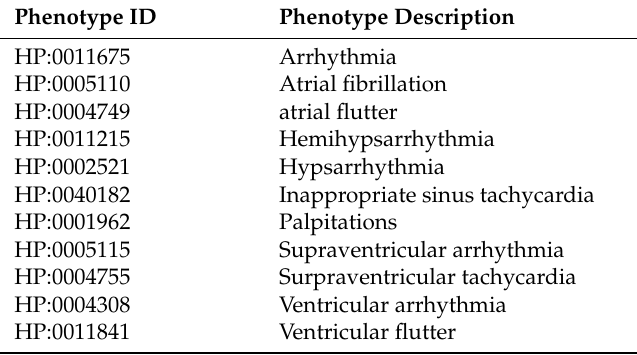
Table 6. UberPheno phenotype terms selected for identification of the differentially regulated sub-network with potential cardiotoxicity of bufadienolide-like chemicals.